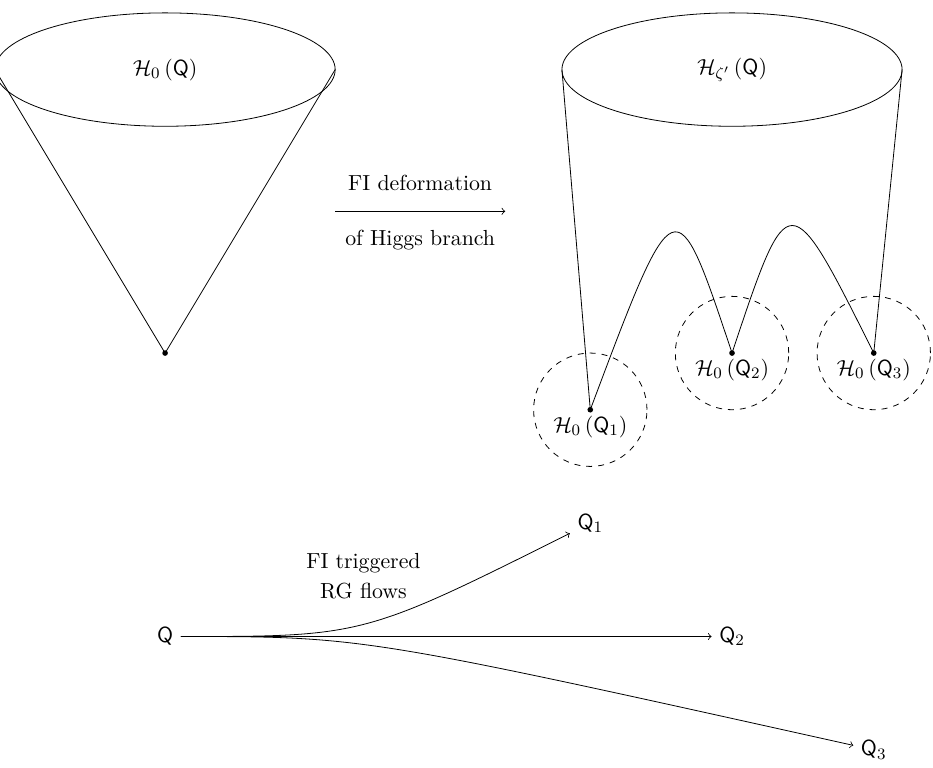
Figure 2 . Top: schematic depiction of the conical Higgs branch H 0 ( Q ) of a good unitary quiver Q with FI term ζ = 0 (left), and the deformed Higgs branch H ζ 0 ( Q ) after turning on an FI term ζ = ζ 0 6 = 0 (right). The singularity of the undeformed Higgs branch splits into several separated singularities, which in turn can be described locally as Higgs branches of good unitary quivers Q which are determined from Q and ζ